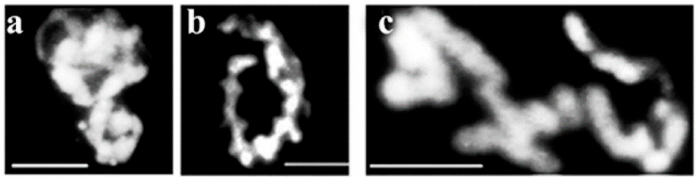
Figure 10. Chromosomes extruded from linearly arranged interphase chromatin. The murine pre-B cell line 70Z = 3-M8 was grown in suspension culture at 37 ◦ C in RPMI 1640 medium supplemented with 10% fetal bovine serum (FBS), 2 mg = mL mycophenolic acid, 150 mg = mL xanthine, 15 mg = mL hypoxanthine and 2 × 10 − 5 M ß-mercaptoethanol. Permeabilization of cells (106) was followed by the restoration of membrane structures, isolation and visualization of chromatin structures, as described in the Methods. Panels ( a , b ) represent structures of linear connectivity between supercoiled chromatin loops, and ( c ) condense early chromosomes. Scale bar 5 µ m each. Modified with permission from